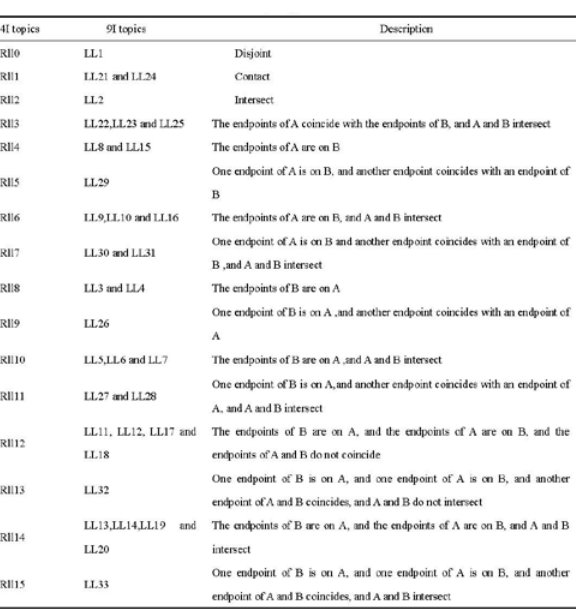
Table 1. Line-line Topological Relation of 4I and 9I